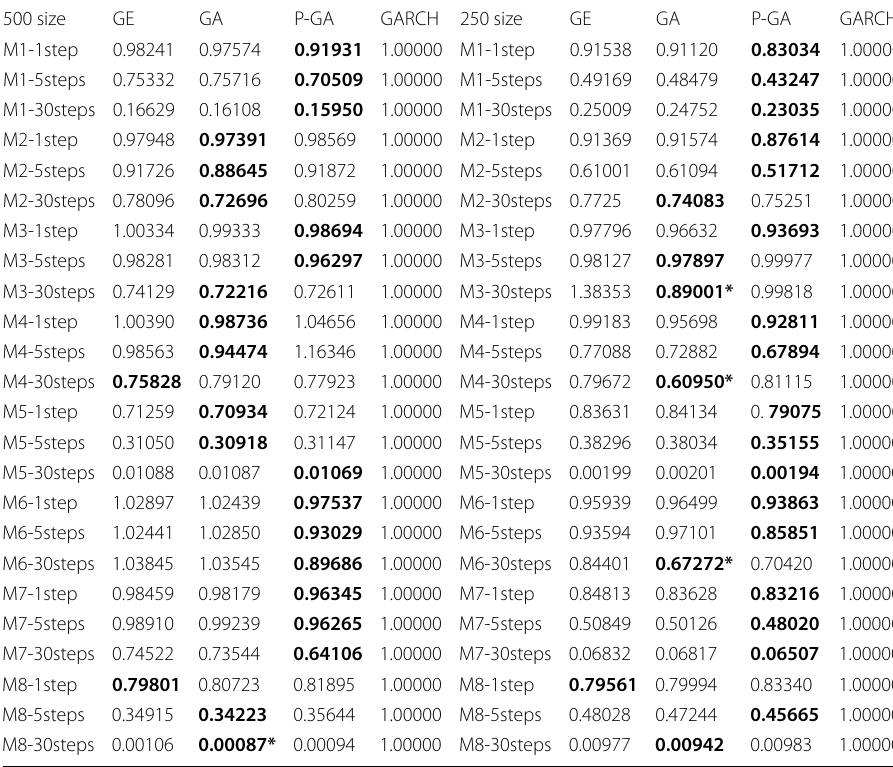
Column names “GA” and “GE” represent GE-NoVaS and GA-NoVaS methods, respectively; “GARCH” represents the GARCH- direct method; and “P-GA” represents the P-GA-NoVaS method. The benchmark is the GARCH-direct method, so numerical values in the table corresponding to the GARCH-direct method are 1. Other numerical values are relative performance compared to the GARCH-direct method. “ Mi - j ”steps denotes using data generated from the Model i to do j steps ahead time-aggregated predictions. The bold value means that the corresponding method is the optimal choice for this data case. Cell with means that the GA-NoVaS method is at least 10 % better than the GE-NoVaS method, or inversely, the GE-NoVaS ∗ method is at least 10 %